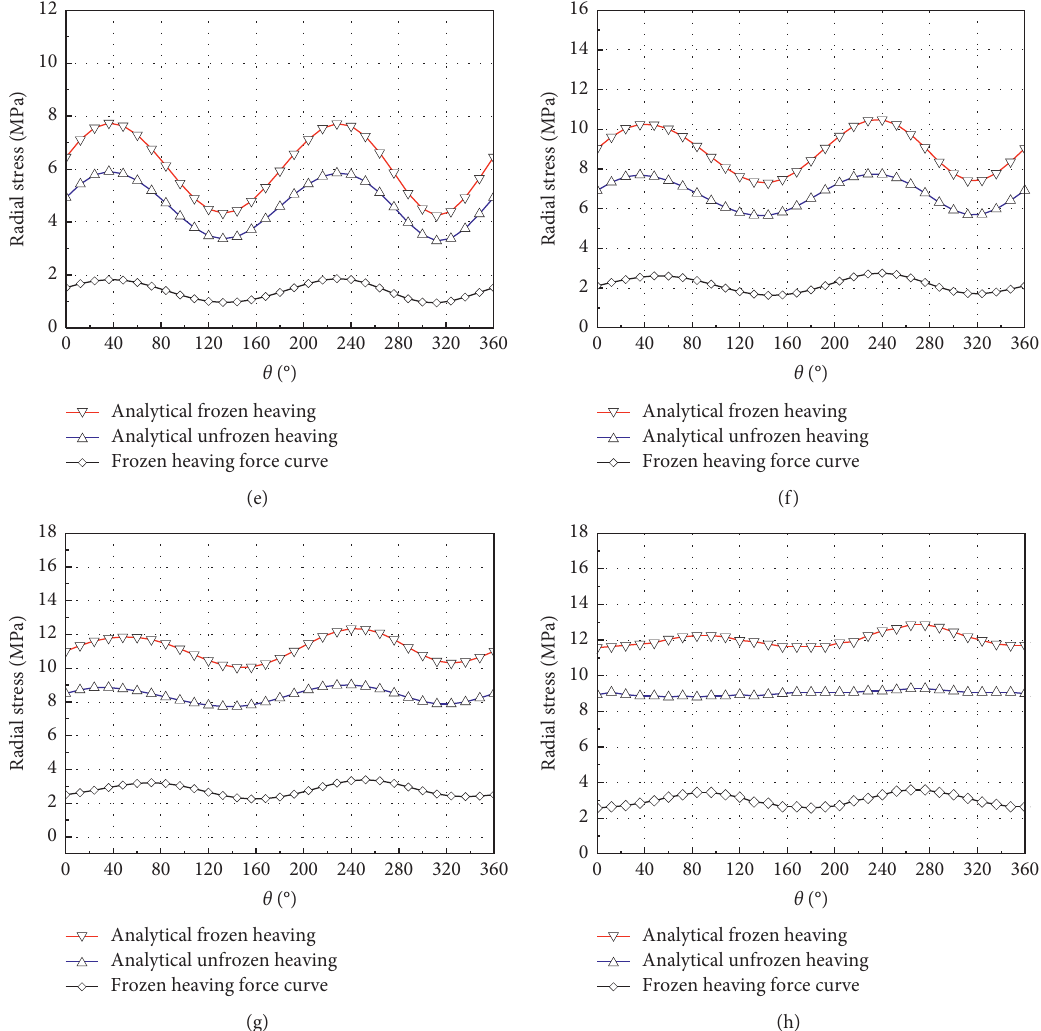
Figure 4: Radial stresses on the outer boundary of the lining for different bedding angles of the surrounding rock. (a) Homogeneous isotropic rock mass. (b) Bedding angles of 0 ° . (c) Bedding angles of 15 ° . (d) Bedding angles of 30 ° . (e) Bedding angles of 45 ° . (f) Bedding angles of 60 ° . (g) Bedding angles of 75 ° . (h) Bedding angles of 90 °